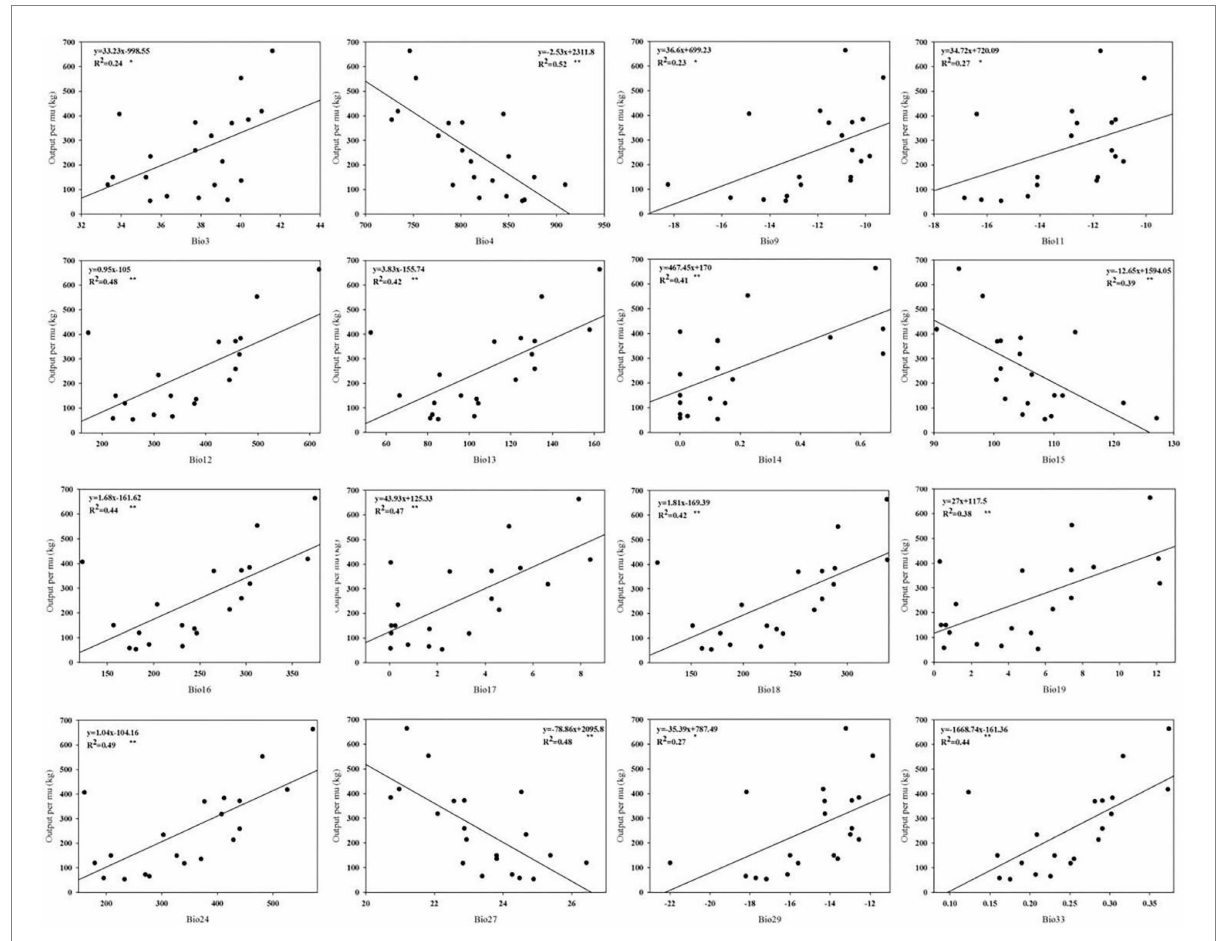
FIGURE 3 Relationships between forage output and 16 bioclimatic